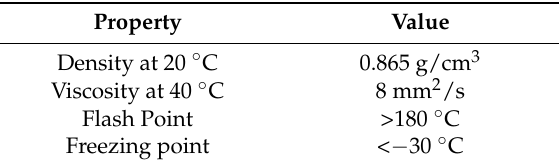
Table 1. Lubricool Technical Data.